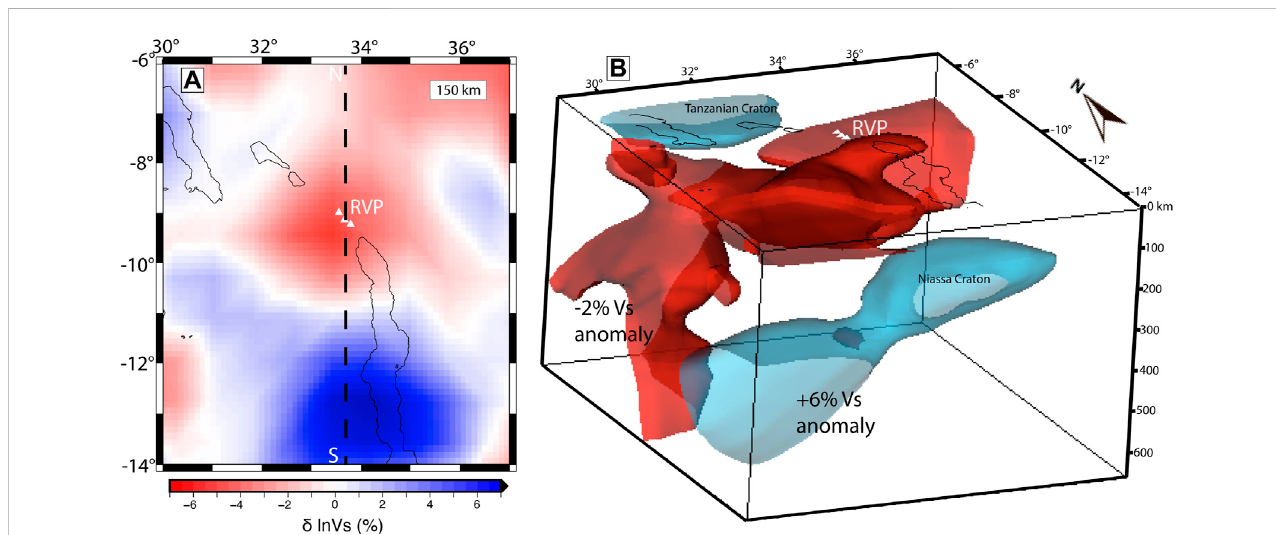
FIGURE 3 (A) . 150 km depth slice of shear-wave velocity anomaly beneath the Rungwe Volcanic Province and surroundings derived from Emry et al. (2019). The velocitiesarerelativetotheAK135globalaverageEarthModel(Kennettetal.,1995).RVP=RungweVolcanicProvince.WhitetrianglesrepresenttheRVP.Black lines indicate the outline of rift lakes. The N-S dashed line represents the cross-section in Figure 5A. (B) . A 3D representation of the shear-wave velocity anomaly beneath the Rungwe Volcanic Province and surroundings derived from Emry et al.